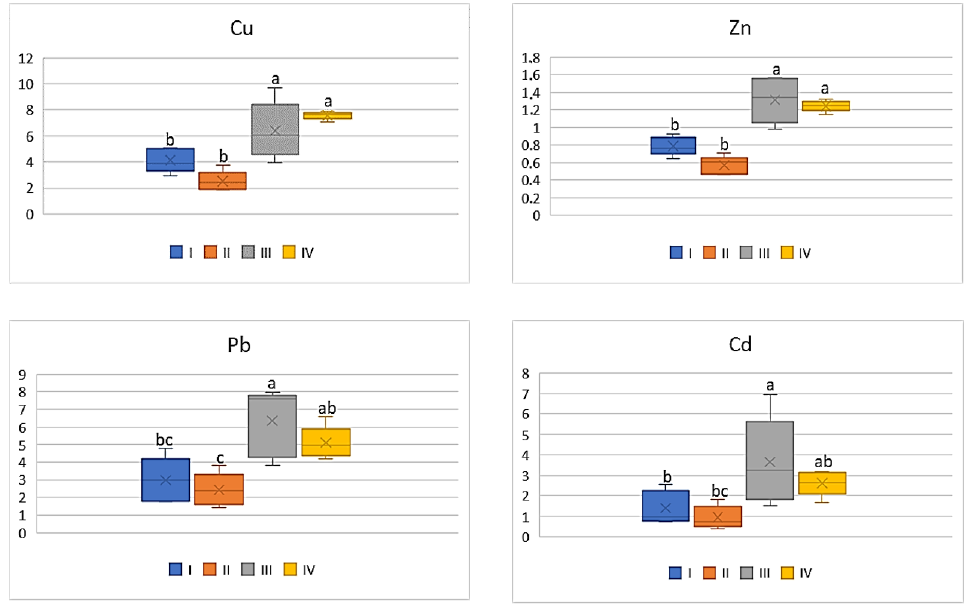
Figure 13. HRI values for beetroot depending on the metal and study zones. The same letters mean no significant differences between the values.